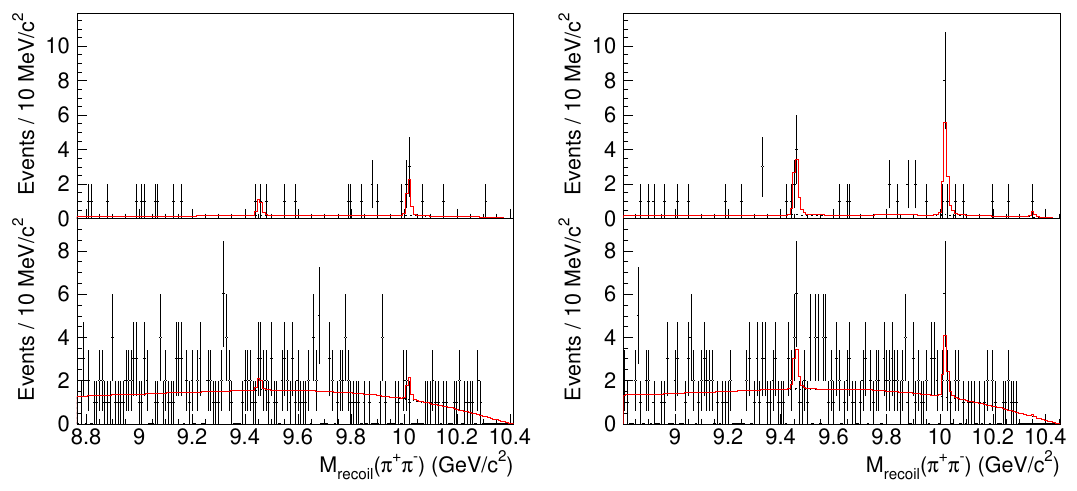
Figure 4 . M recoil ( (cid:25) + (cid:25) (cid:0) ) distributions in the data samples No. 4 (left) and 5 (right); the numbering is given in table 1. Top and bottom panels correspond to (cid:22) + (cid:22) (cid:0) (cid:25) + (cid:25) (cid:0) and e + e (cid:0) (cid:25) + (cid:25) (cid:0) (cid:12)nal states, respectively. Results of the (cid:12)t (red solid histogram) and their background components (black dotted histogram) are also